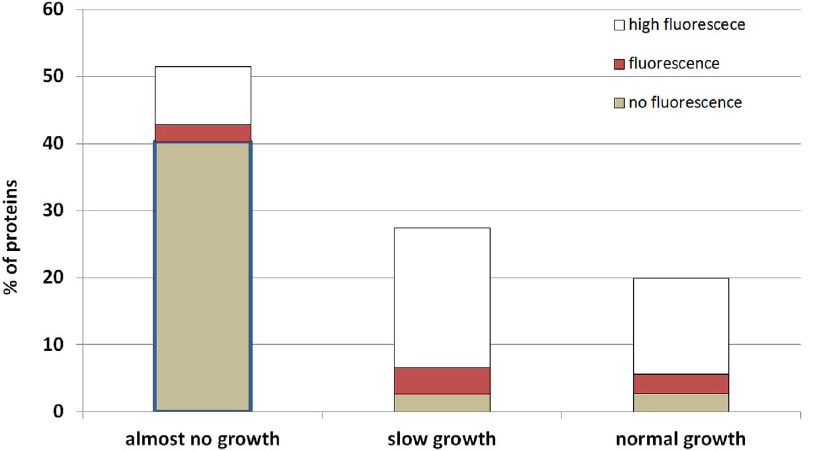
Figure 1. Effects on growth and GFP fluorescence of proteins on overexpression. Protein overexpression was induced by adding IPTG to ASKA clones grown in LB medium at 37C, and effects on growth and GFP fluorescence was classified into three categories each (‘‘almost no growth’’, ‘‘slow growth’’, ‘‘normal growth’’ and ‘‘high fluorescence’’, ‘‘fluorescence’’, ‘‘no fluorescence’’ respectively) [2]. We defined ‘‘toxic’’ proteins as those classified as ‘‘almost no growth’’ and ‘‘no fluorescence’’ (marked with blue outline). Overall 40% of clones fall into this category